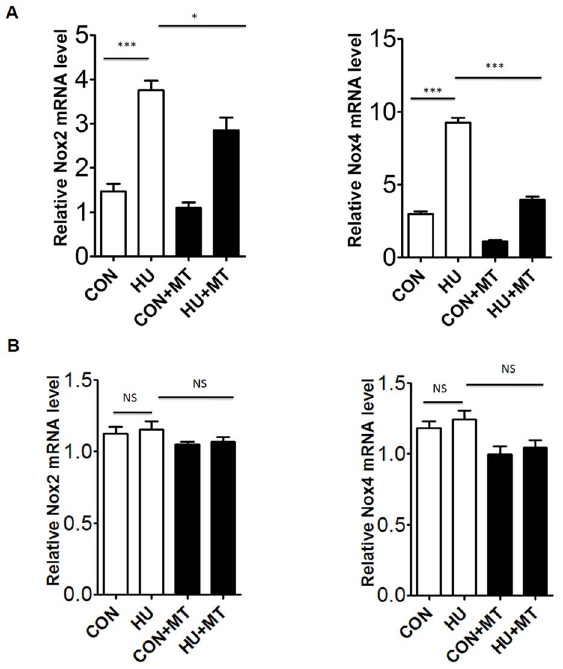
Figure 4. The mRNA expression of Nox2 and Nox4 in rat cerebral (A) and mesenteric (B) arteries. The mRNA abundance was analyzed by quantitative polymerase chain reaction. CON, control; HU, hindlimb unweighting; CON + MT, mitoTEMPO-treated control; HU + MT, mitoTEMPO-treated HU. Values are mean 6 SEM. * P , 0.05 for HU vs. HU + MT and *** P , 0.001 for HU vs . control for Nox2 , *** P , 0.001 for HU